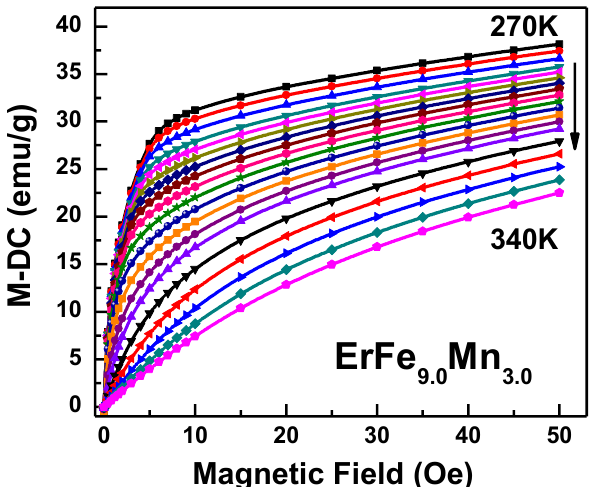
Figure 6. Isothermal magnetization curve of ErFe 9.0 Mn 3.0 .